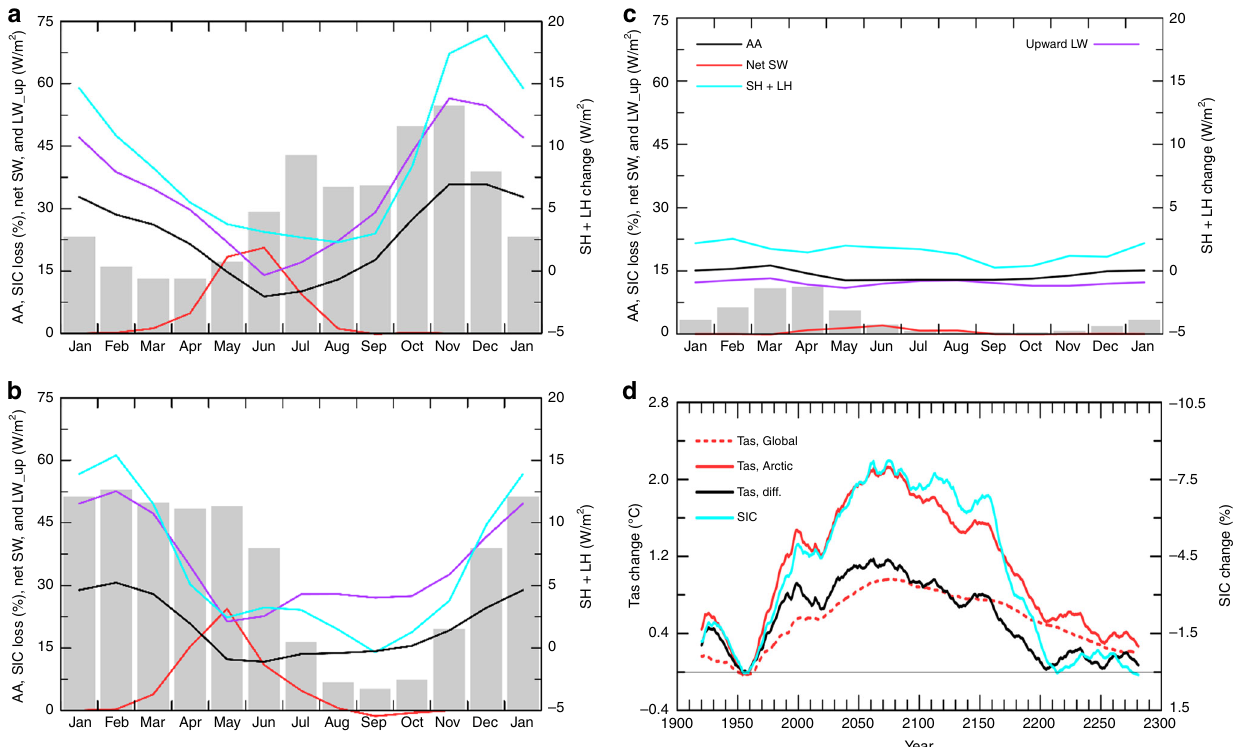
Jan Feb Mar Apr May Jun Jul Aug Sep Oct Nov Dec Jan